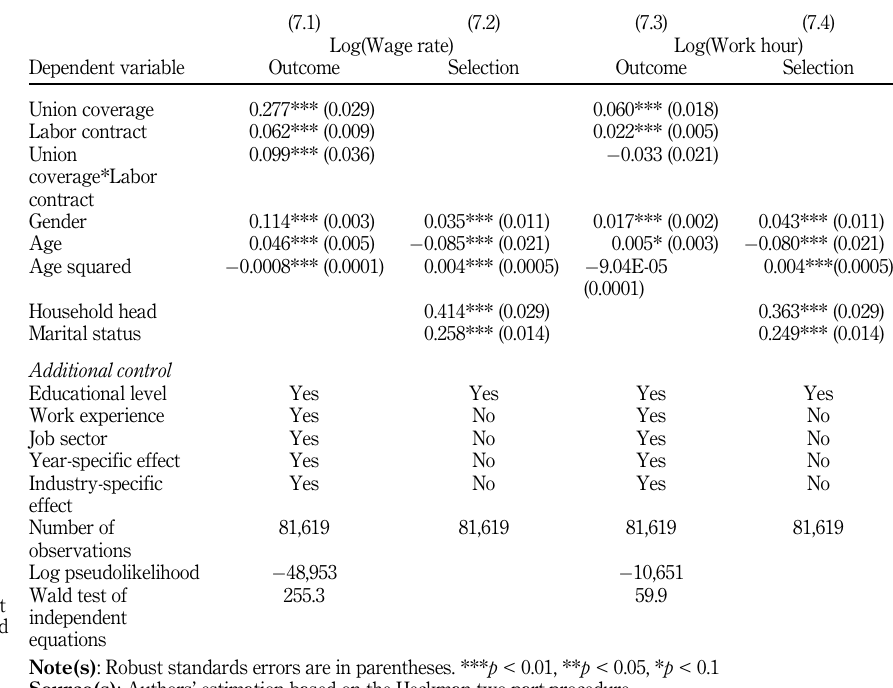
Table 7. Complementary